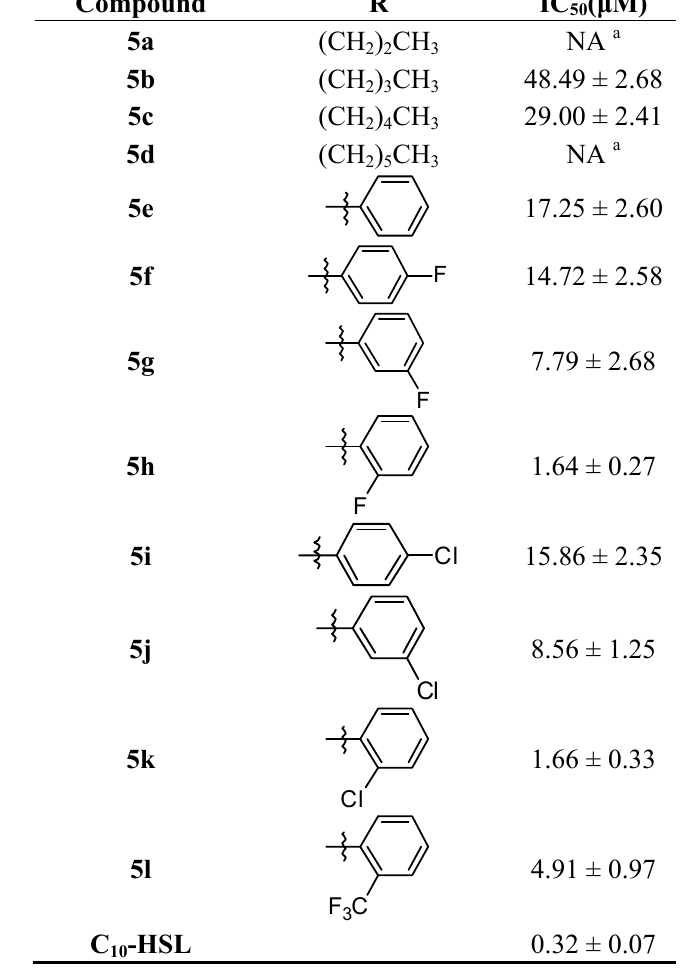
values of 5a – l for inhibiting violacein 50